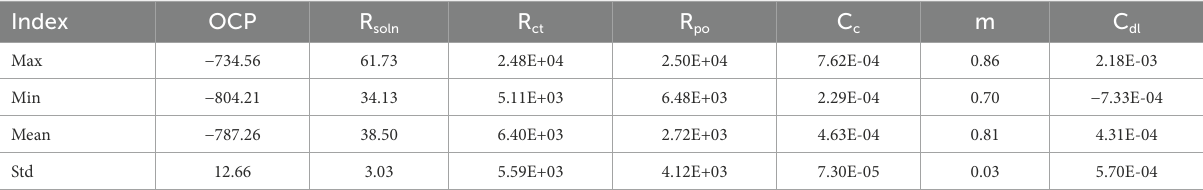
TABLE 2 Characteristics of the VAE based synthetic corrosion data used in machine learning model.